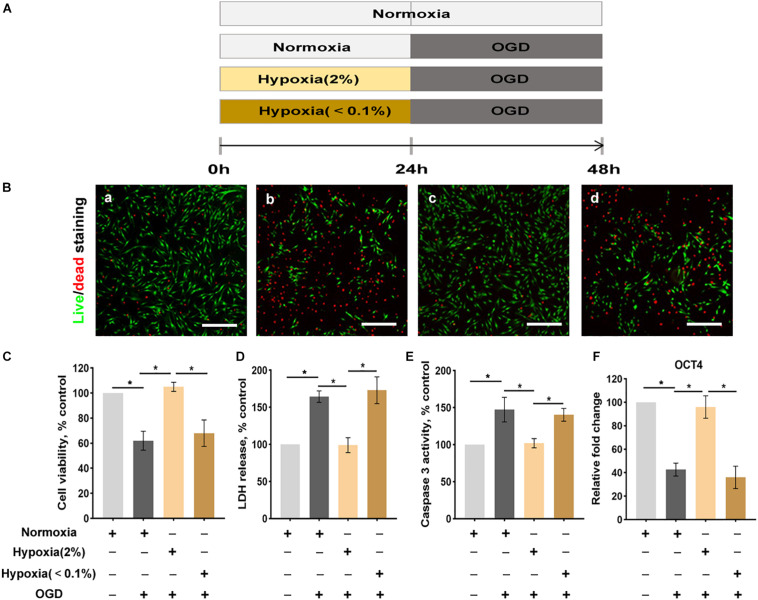
Hypoxia enhances the conditions of ASCs exposed to the oxygen-glucose deprivation (OGD) environment. (A) The OGD model in vitro. (B) The live/dead staining of ASCs: normoxia for 48 h (a), normoxia 24 for h followed by OGD for 24 h (b), hypoxia (2% O2) 24 h followed by OGD for 24 h (c), hypoxia (< 0.1% O2) for 24 h followed by- OGD for 24 h (d). Scale bar = 200 μm. (C) Hypoxia (2% O2) significantly improves cell viability (live/dead staining), (D) cellular injury (LDH release), (E) apoptosis (caspase 3 activity), and (F) stemness (Oct4 expression) of ASCs exposed to OGD. n = 6 per group; *denotes P < 0.05). LDH, lactate dehydrogenase.